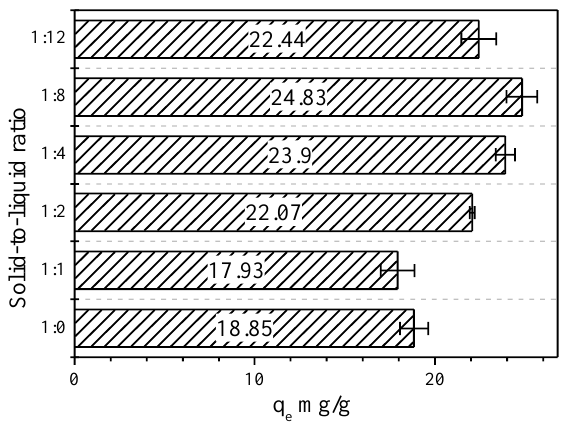
Figure 8. Effect of solid – liquid ratio on Cd adsorption.